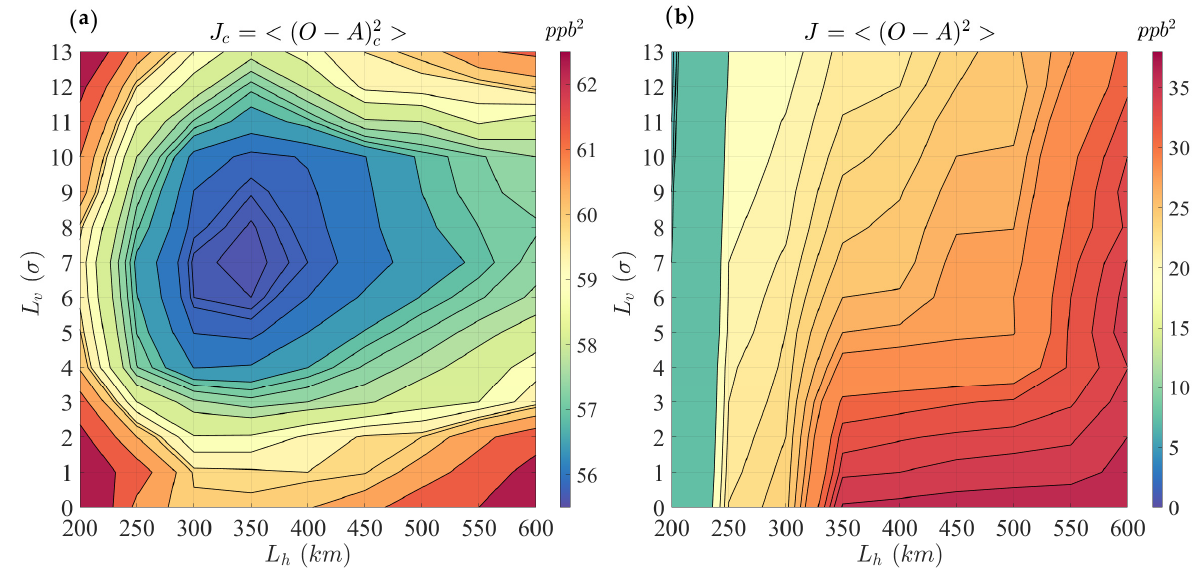
Figure 2. Estimation of the horizontal length scale ( L h , x -axis) and the vertical length scale ( L v , y -axis) together through ( a ) a cross-validation cost function of passive observations J c = with ( b ) a cross-validation cost function of active observations J =